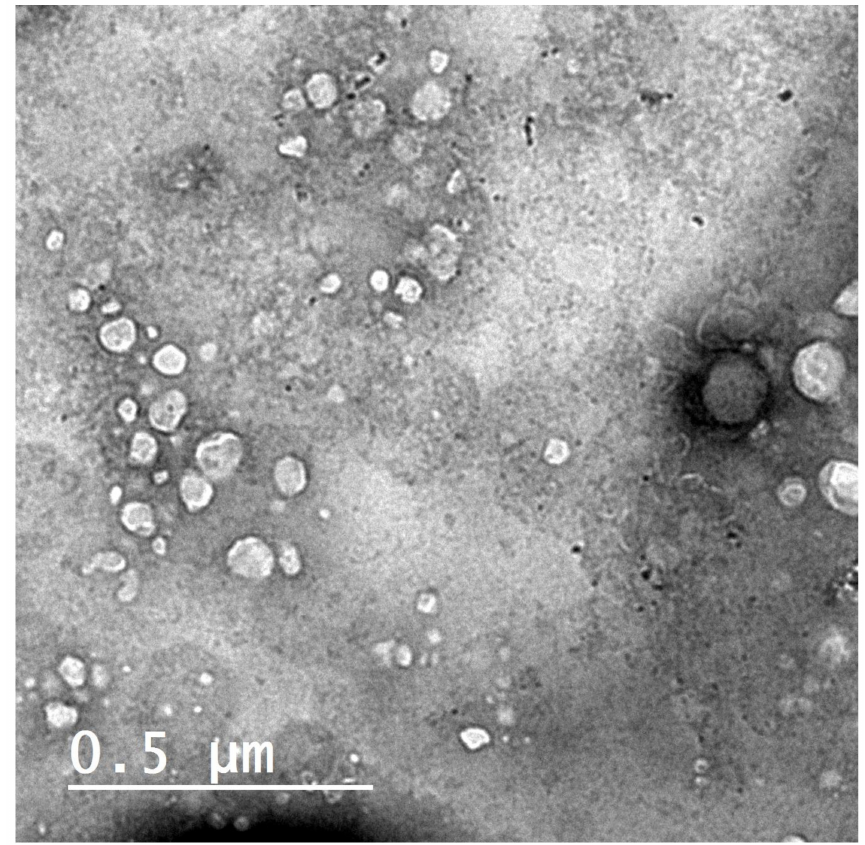
Figure 1. Transmission electron micrograph of the prepared liposomes P-lip (F4) when stained with uranyl acetate (2.5% w / v ) with scale 0.5 µ